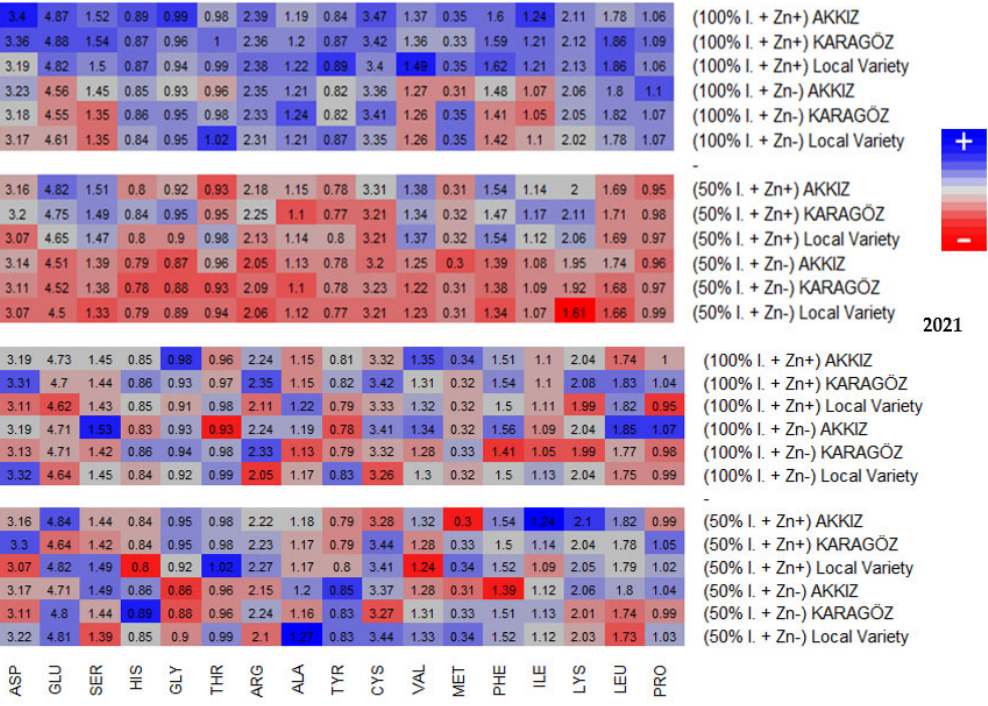
Figure 4. Mean values of grain amino acid contents. Table 4. ANOVA of amino acids of cowpea cultivars (*: significant ‐ : nonsignificant).